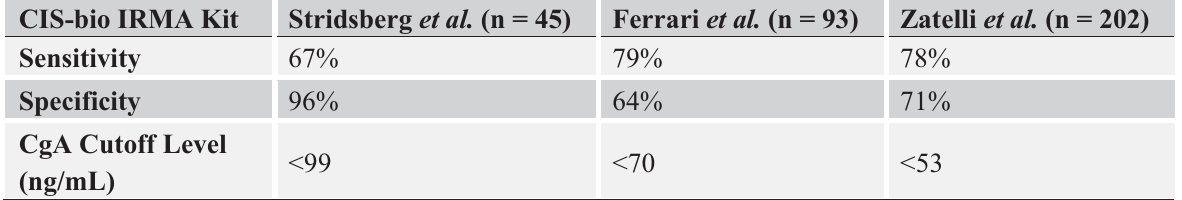
Table 7. Sensitivities and specificities of CgA (CIS-bio IRMA kit) in different studies.